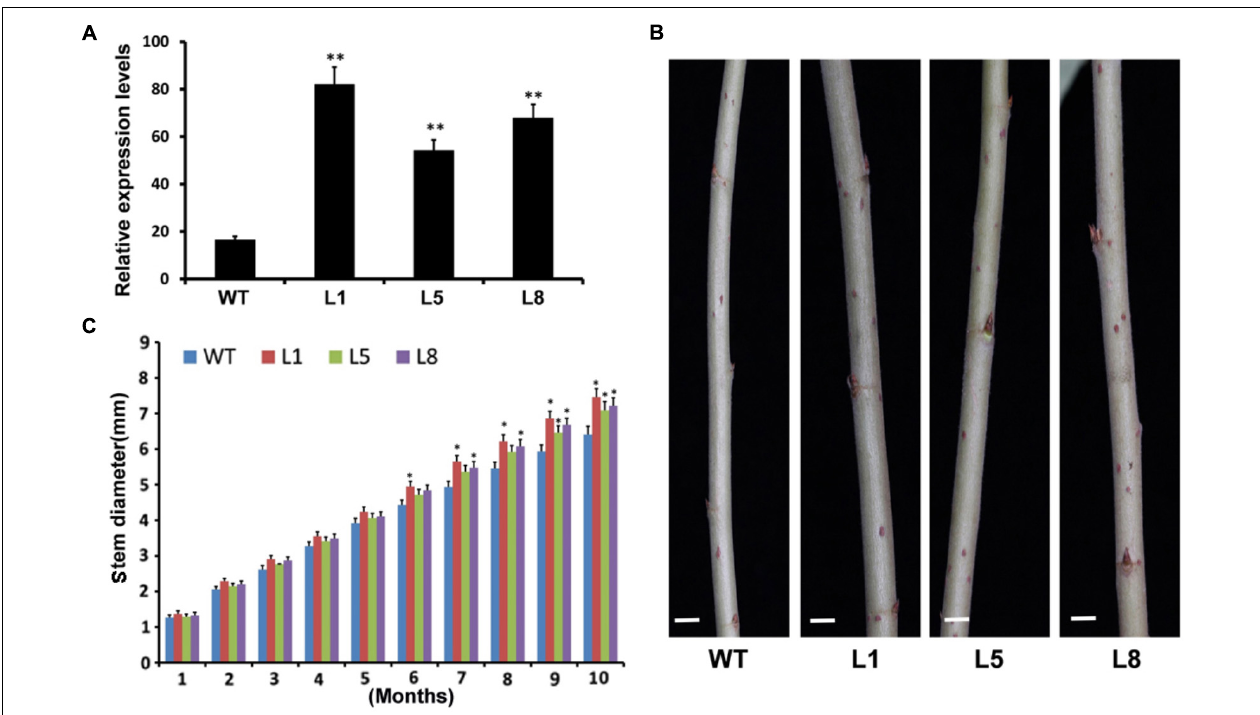
FIGURE 5 | Phenotypes of transgenic poplar overexpressing PtoMYB74 . (A) The expression levels of PtoMYB74 in wild-type and three independent transgenic lines by RT-qPCR (after MIQE-guidelines). The poplar 18S rRNA was used as an internal reference. (B) Stem microphotographs of the 10-month-old wild-type and PtoMYB74 overexpression lines (L1, L5, and L8). (C) Stem diameters of wild-type and PtoMYB74 overexpression lines (L1, L5, and L8). Error bars represent ± SD from three biological repeats. Student’s t -test: ∗ P < 0.05; ∗∗ P < 0.01. Bars: C = 5 mm.